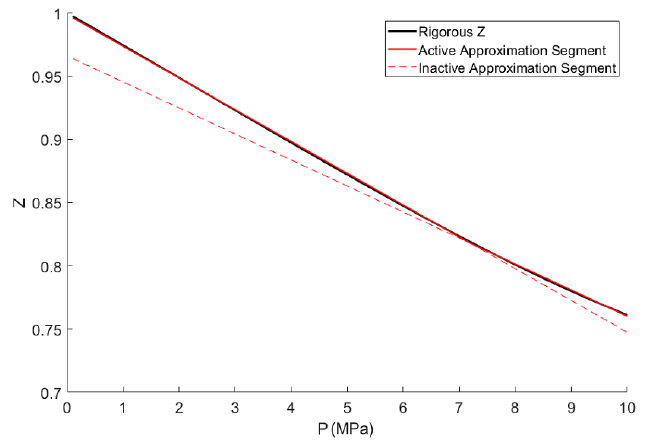
Figure 8. Piecewise-linear function generated for approximating 289.5 K compressibility factor isotherm, consisting of two line